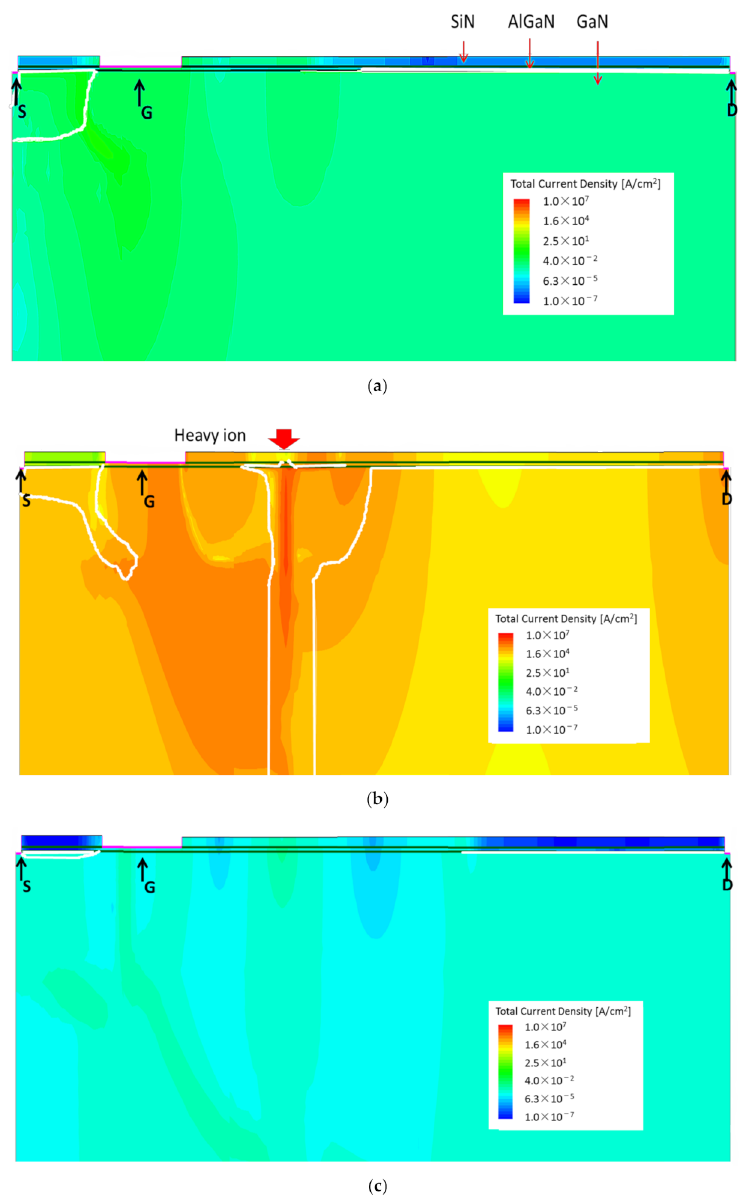
Figure 9. The cross-sections of the total current density with time after the heavy-ion striking at P5: ( a ) before heavy-ion striking, ( b ) 0.05 ns after heavy-ion striking, and ( c ) 50 ns after heavy-ion striking. The white line represented the depletion